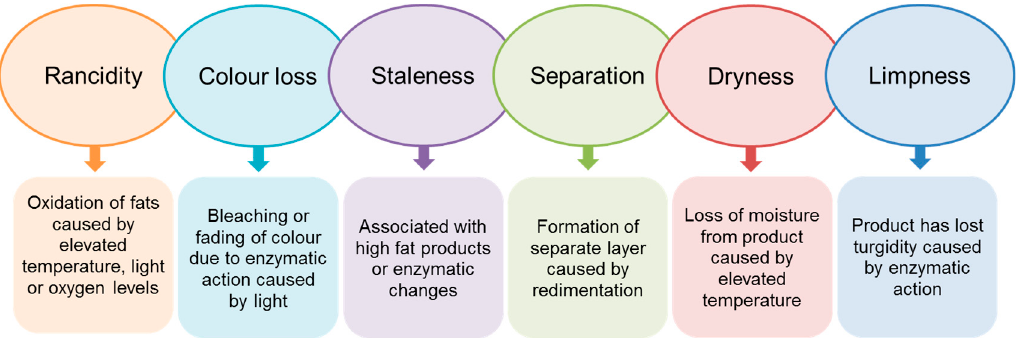
Figure 7. Non-microbial spoilage physical defects in foods [136].